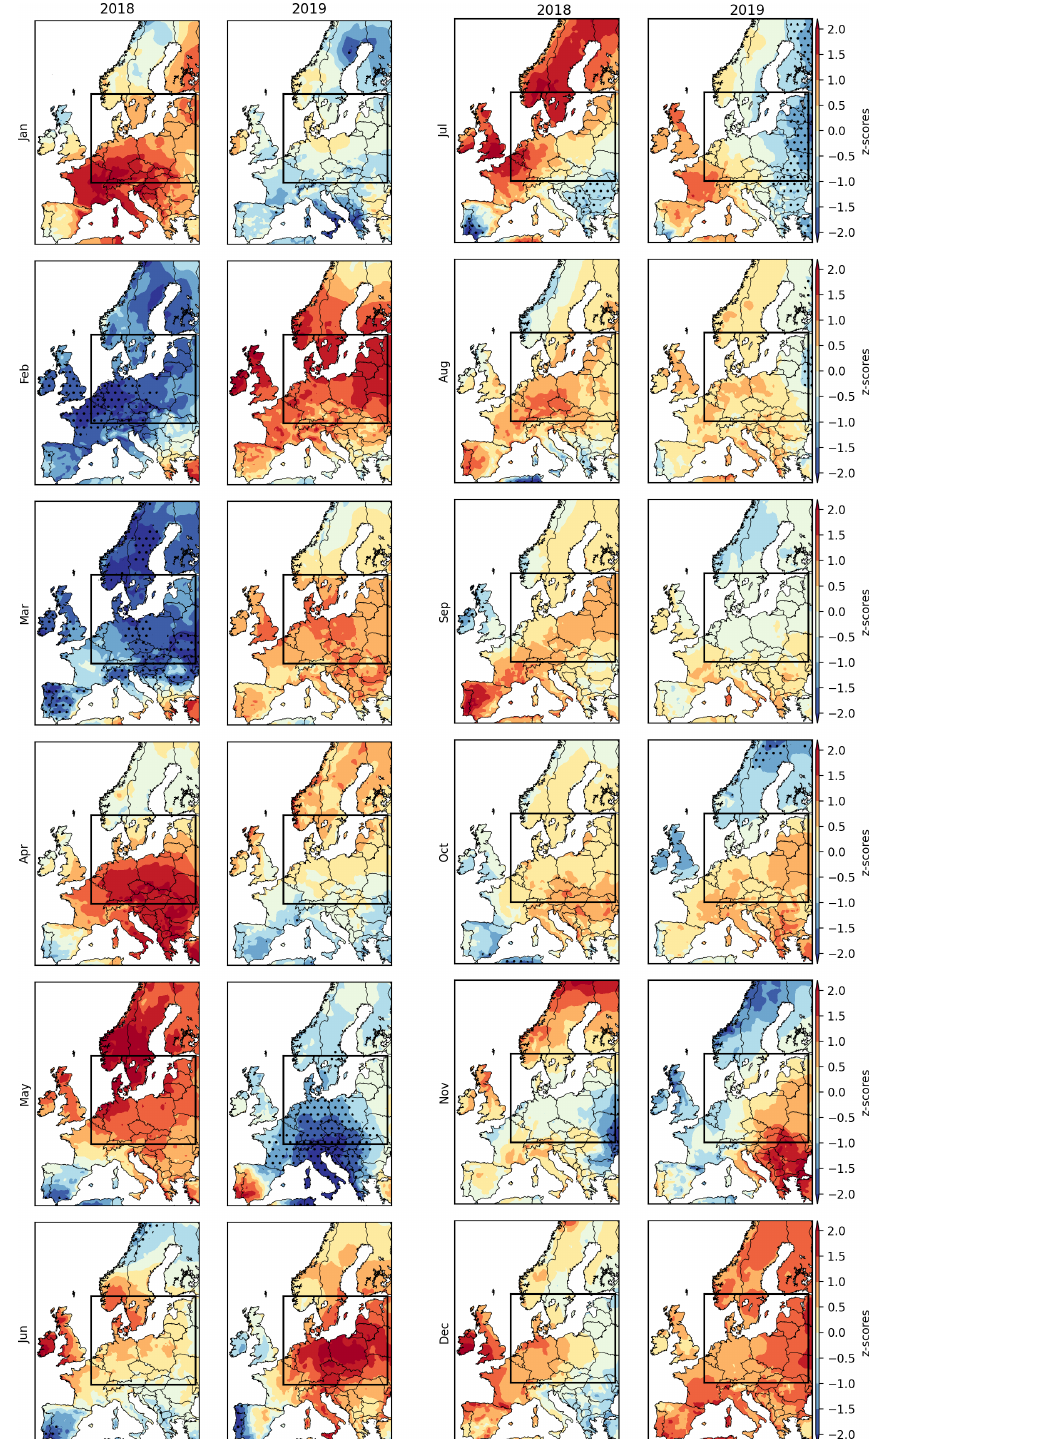
Figure B1. Monthly temperature anomalies during 2018 and 2019. The rectangle indicates the study region.